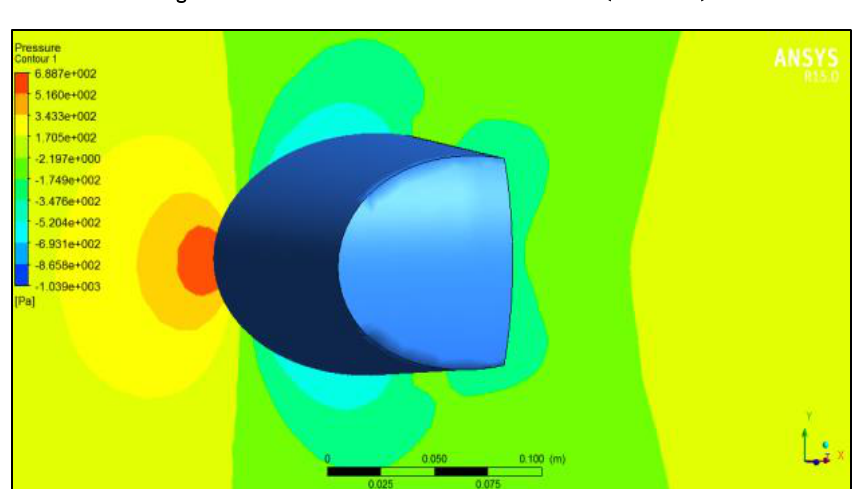
Figure 15. Pressure contours in proposed mirror (120